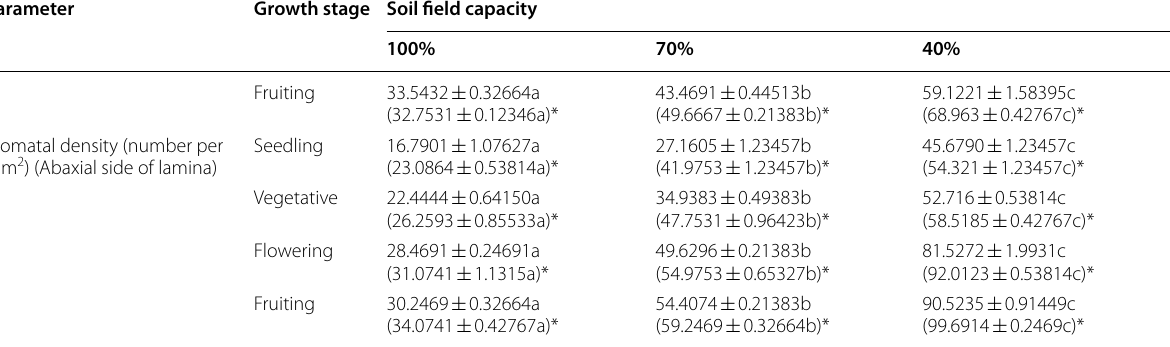
Table 5 Two‑way ANOVA of stomatal criteria of Ocimum basilicum under Drought and mycorrhiza, Error 12